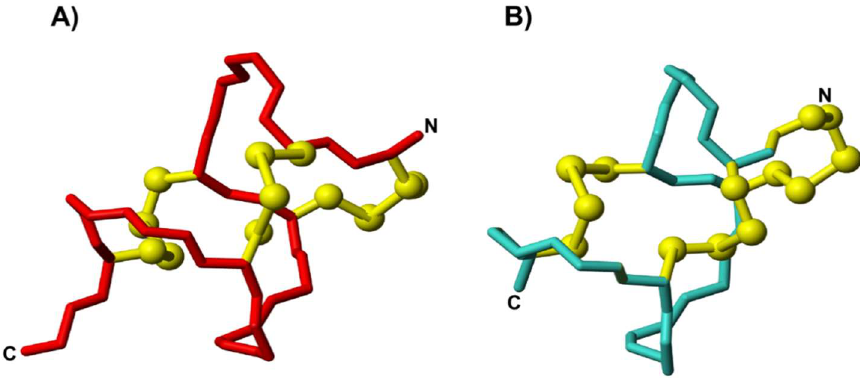
Figure 5. Three-dimensional structures of MC12-linaclotide and STp (5-17). ( A ) MC12-linaclotide determined in the presence of 100 mM SDS and ( B ) crystal structure of STp (5-17), PDB code: 1ETN. The figure was generated using MOLMOL [24].